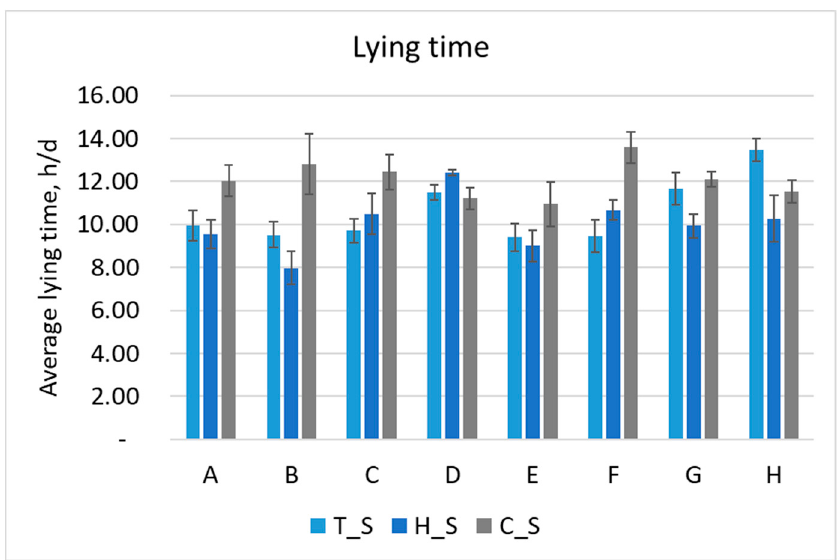
Figure 4. Average lying time in every farm (A to H) for the three measuring periods (thermoneutral = T_S, hot = H_S and cold = C_S). Vertical bars express the standard deviation. During C_S, in which the average THI never exceeds 52, the lying time of the monitored cows ranges between 10.9 (in Farm E) and 13.6 h/d (in Farm F). During the other two periods, instead, a